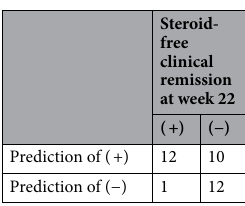
Table 5. Predictive ability of the model steroid-free clinical remission at week 22 in Cohort 2. Positive predictive value: 54.5%. Negative predictive value: 92.3%. Accuracy: